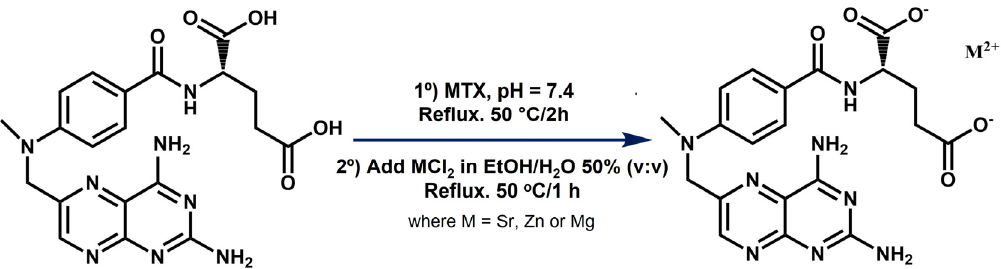
Figure 1. Scheme for the synthesis of SrMTX, ZnMTX, and MgMTX complexes. The synthesis process retrieved highly pure products, as shown in Figure 2, by Energy Dispersive X-ray analysis (EDAX). MTX derivatives were isolated with presence of minor chlorine impurities, always under 1% in weight.